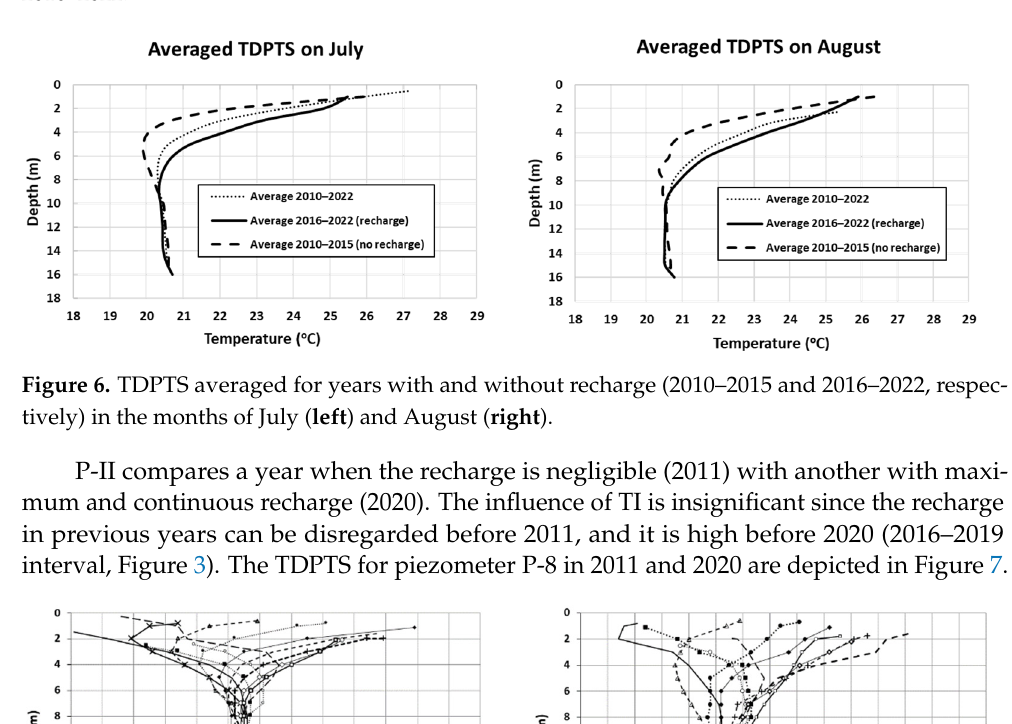
Figure 5. Total volume of seawater used for irrigation in July ( left ) and August ( right ) for the period 2010–2022.